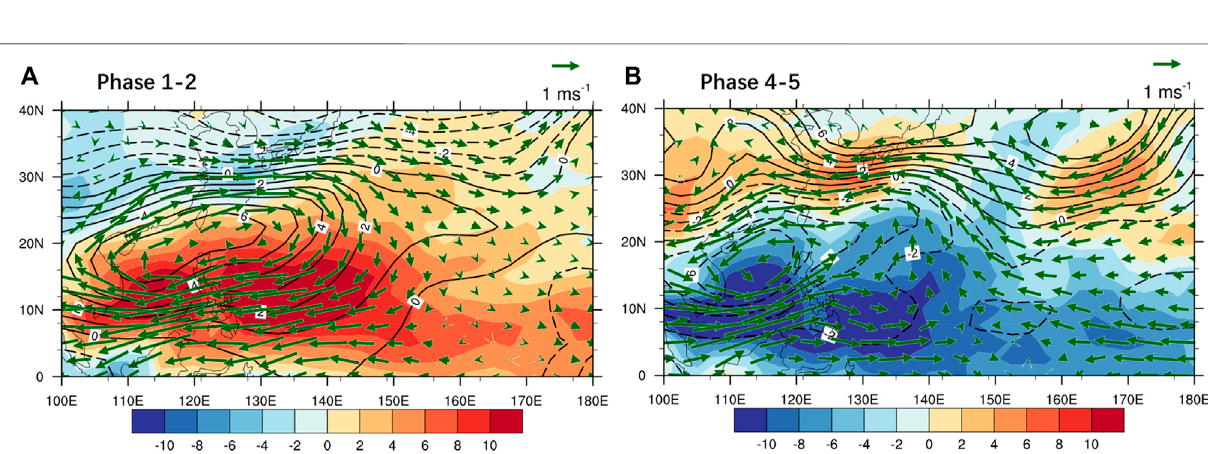
FIGURE 8 | Frequency of MJO phases during (A) July and (B) early August in 2020 (red bars) and their corresponding climatology (blue bars).